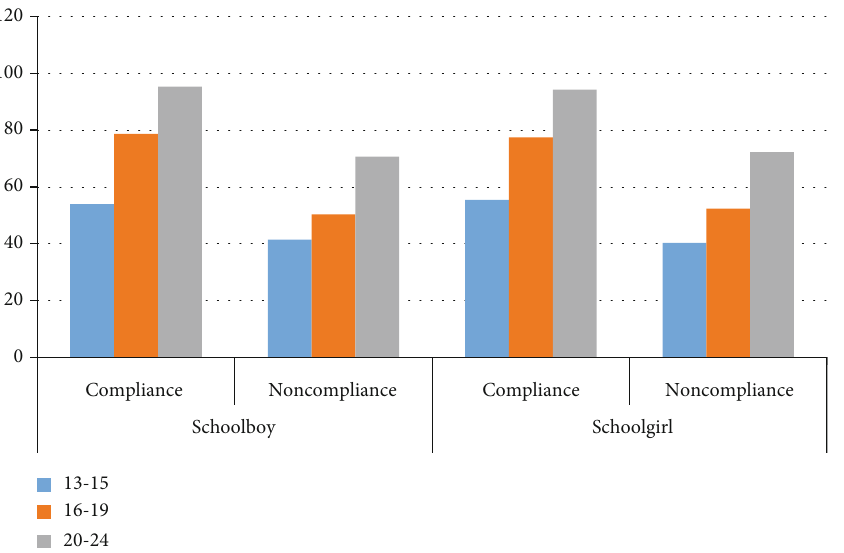
Figure 6: (Compliance/non-compliance) physical fi tness test compliance rate of students of di ff erent